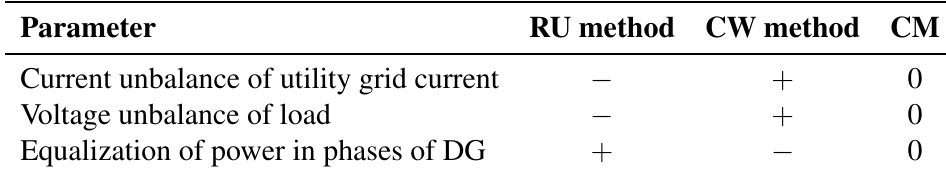
Table 2. Grid-connected microgrid, one DG